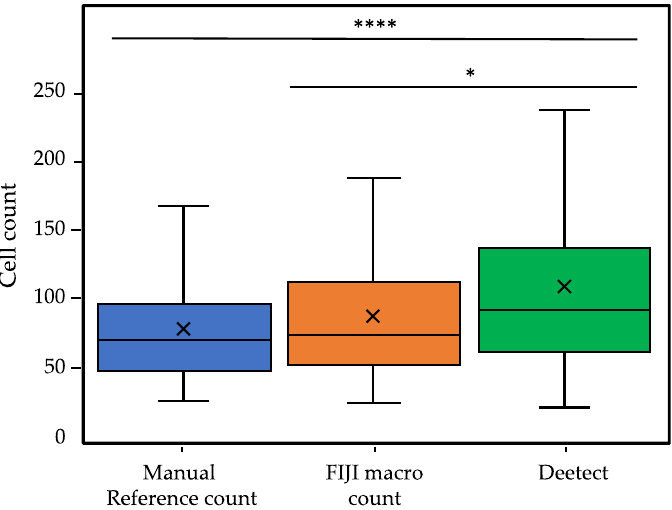
Figure 8. Comparison of application of the three methods to a sample region on a 2-z-substack. Regions with clustered nuclei that can still be visually distinguished (green circle, left panel) are not completely resolved by the semantic segmentation approach with Fiji (green circle, center panel) but are resolved by Deetect (green circle, right panel). In areas where it is difficult to distinguish nuclei borders visually (red circles) Deetect senses cell conglomerates (gray outlining, right panel) and estimates the number of cells present through the post-processing rules.